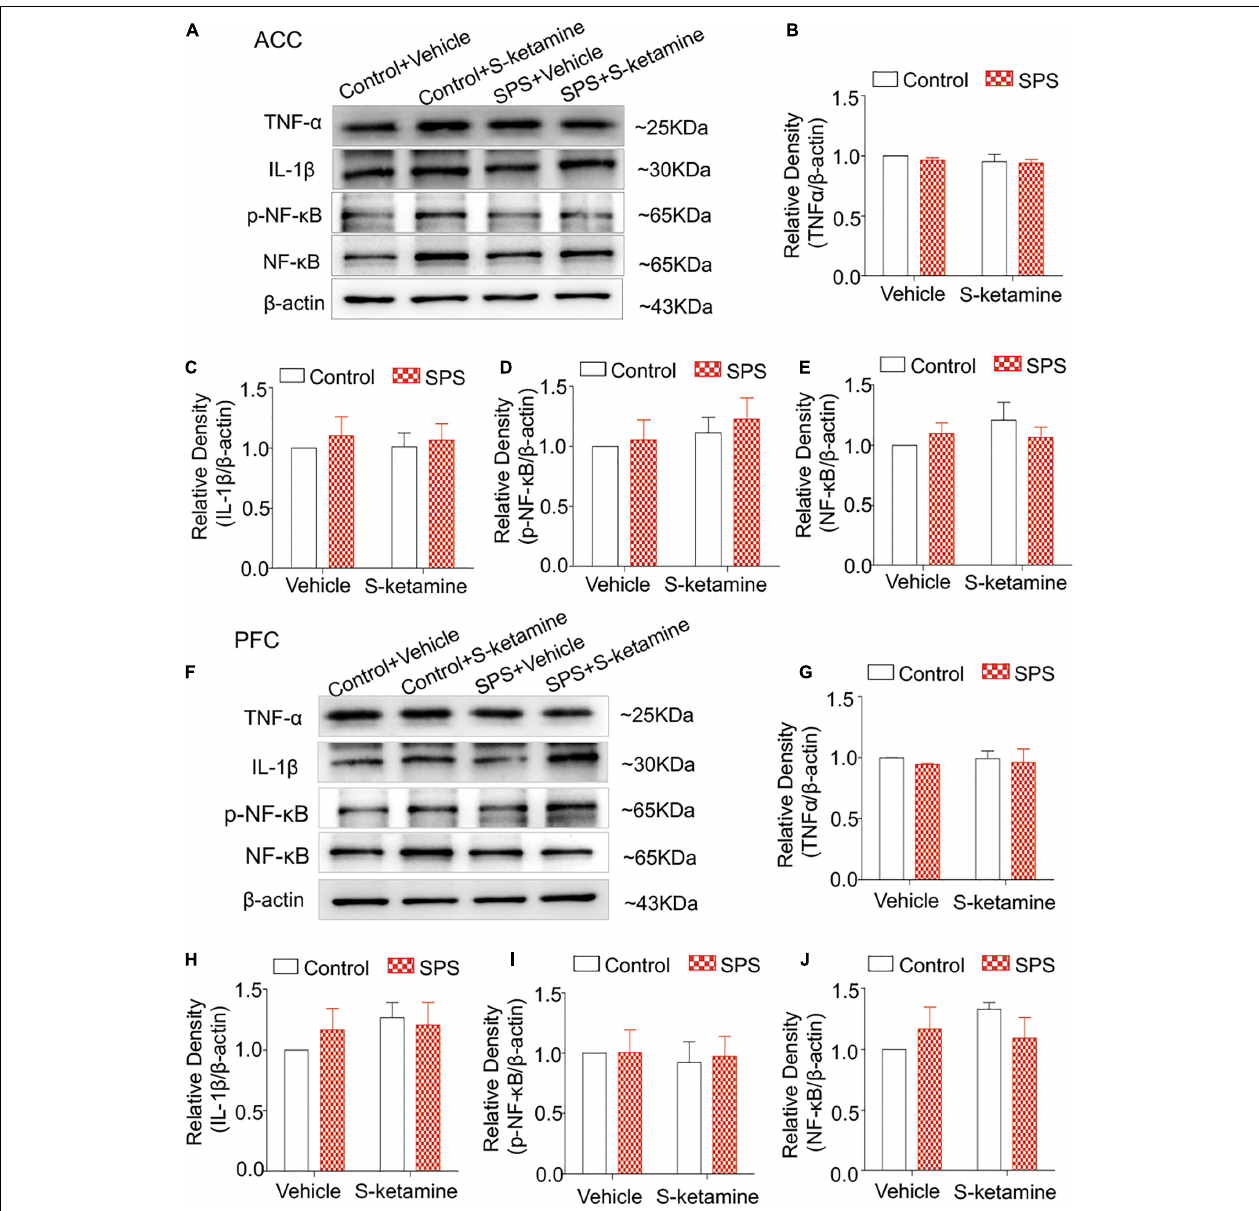
FIGURE 3 | S-ketamine does not influence pro-inflammatory cytokines in the anterior cingulate cortex and prefrontal cortex. Rats were randomly assigned into control + vehicle group, SPS + vehicle group, control + S-ketamine 5 mg/kg group and SPS + S-ketamine 5 mg/kg group. n = 3 per group. (A) Protein levels